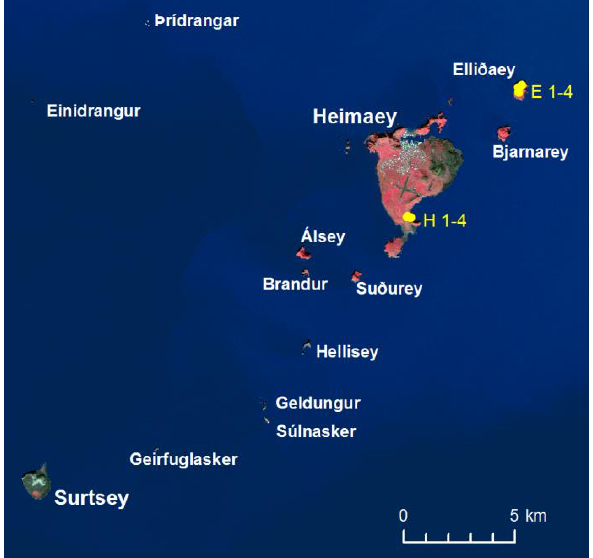
Figure 1. Surtsey and other Vestmannaeyjar islands on an infrared Rapid Eye image from 28 August 2012. Areas with dense vegeta- tion appear in red colour, e.g. gull colony on Surtsey. Location of vegetation plots sampled on Elliðaey and Heimaey in 2013 is shown in